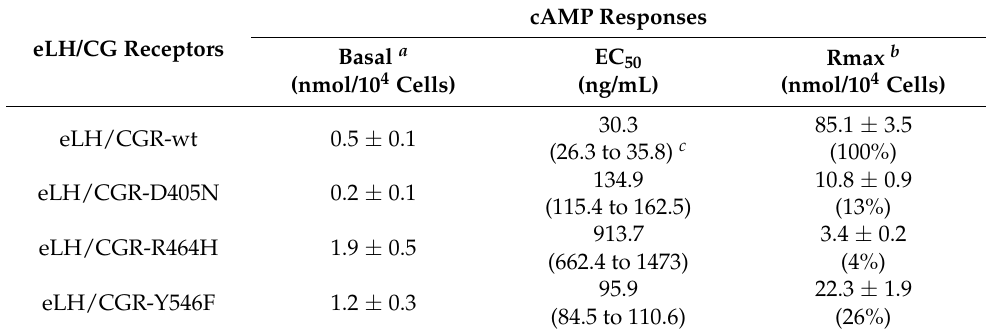
Figure 4. cAMP production stimulated by recombinant eCG (rec-eCG) treatment in CHO-K1 cells transfected with the inactivating eLH/CGR mutants. CHO-K1 cells transiently transfected with wild-type eLH/CGR and inactivating eLH/CGR mutants (D405N, R464H, and Y546F) were stimulated with rec-eCG for 30 min. Total cAMP accumulation was determined using homogeneous time-resolved fluorescence (HTRF). The empty circles denote wild-type eLH/CGR, and the black circles denote the mutants. The data were subtracted from the results of the mock-transfected cells. Representative data was obtained from three independent experiments. Table 2. Bioactivity of eLH/CG receptors in cells expressing inactivating receptor mutants.